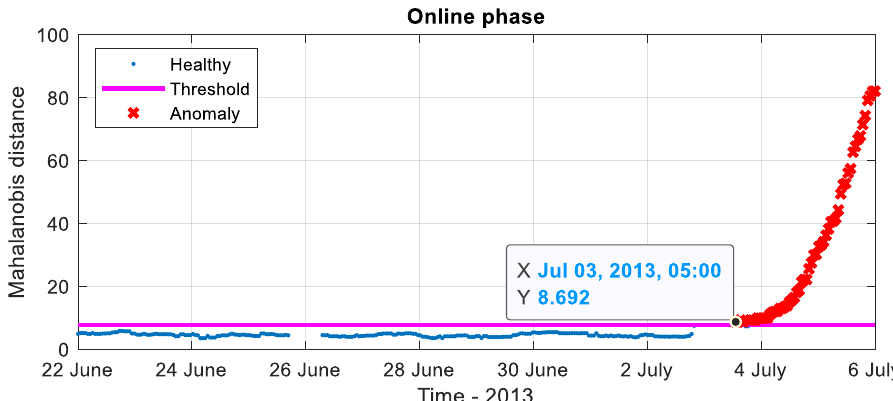
Figure 8. Online testing results for an industrial pump from 22 June 2013 to 6 July 2013 by SAE model. (Blue points: healthy data; red points: anomalies; magenta line: reference MD thresholds).